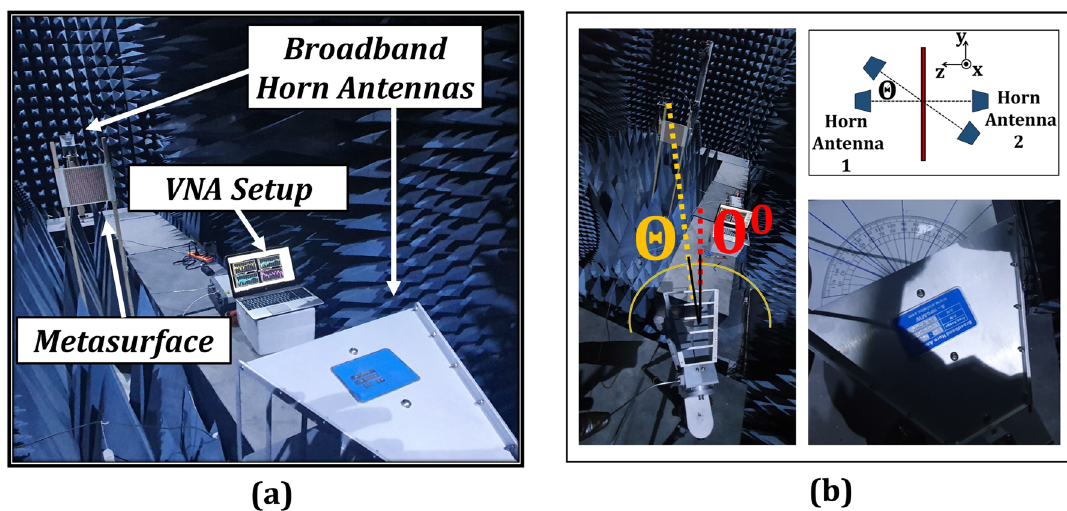
Figure 15. ( a ) Measurement setup ( b ) Measurement at oblique incidences.